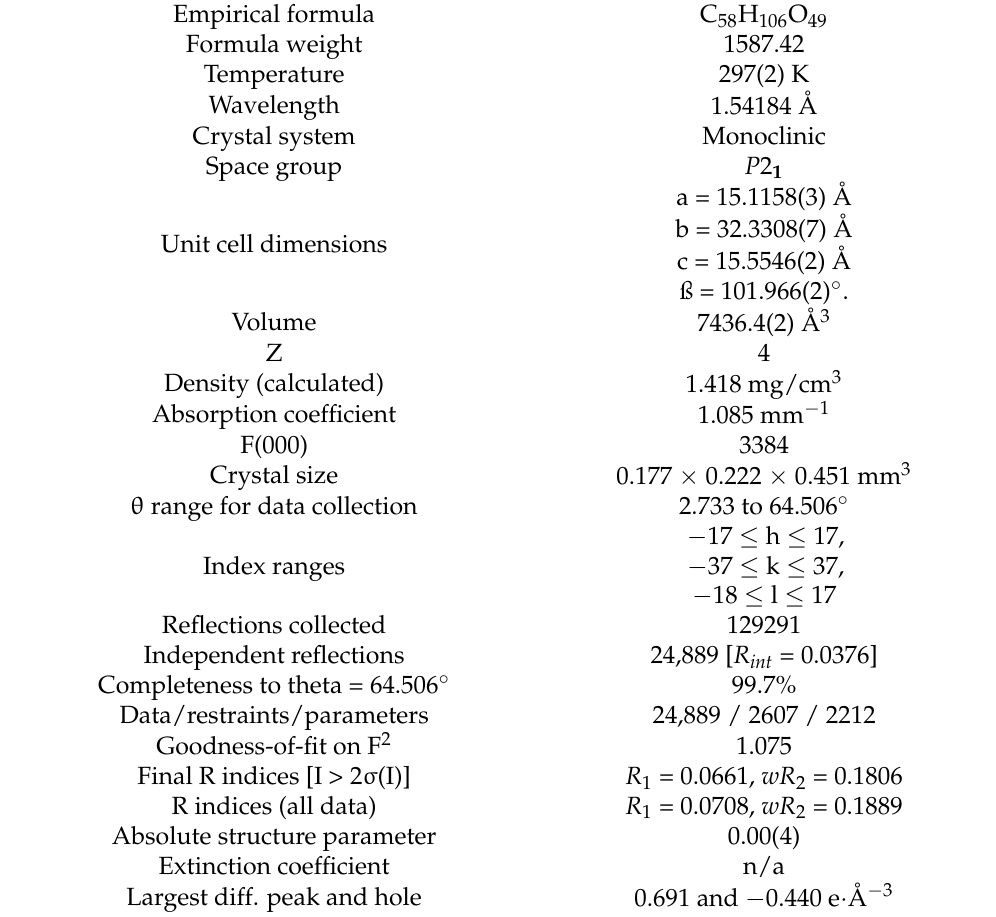
Table 1. Crystal data and structure refinement